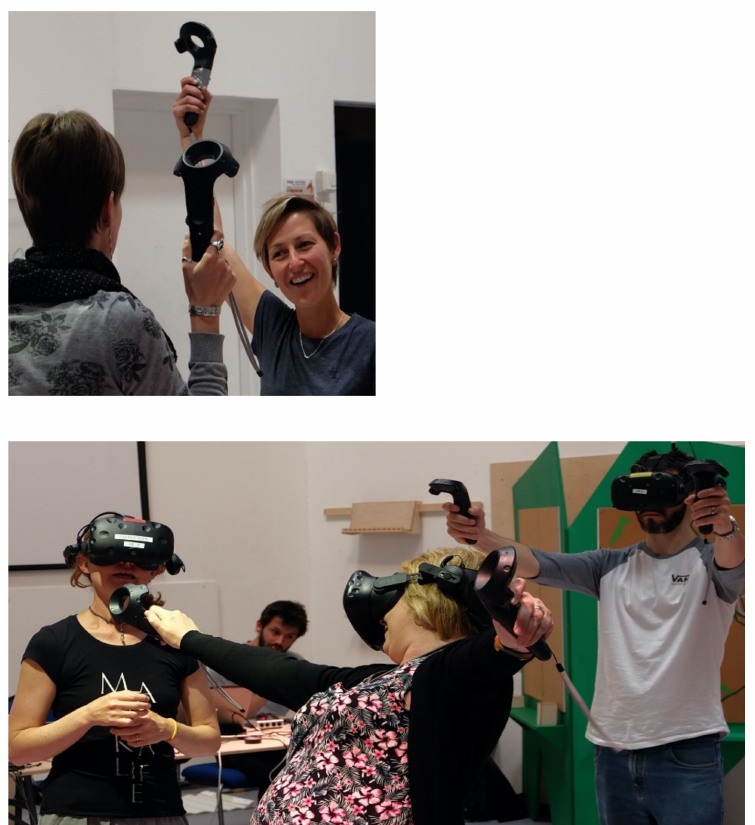
Figure 5. TFS workshops, tasks 3, 4 and 5—Knowle West Media Centre, 2018.